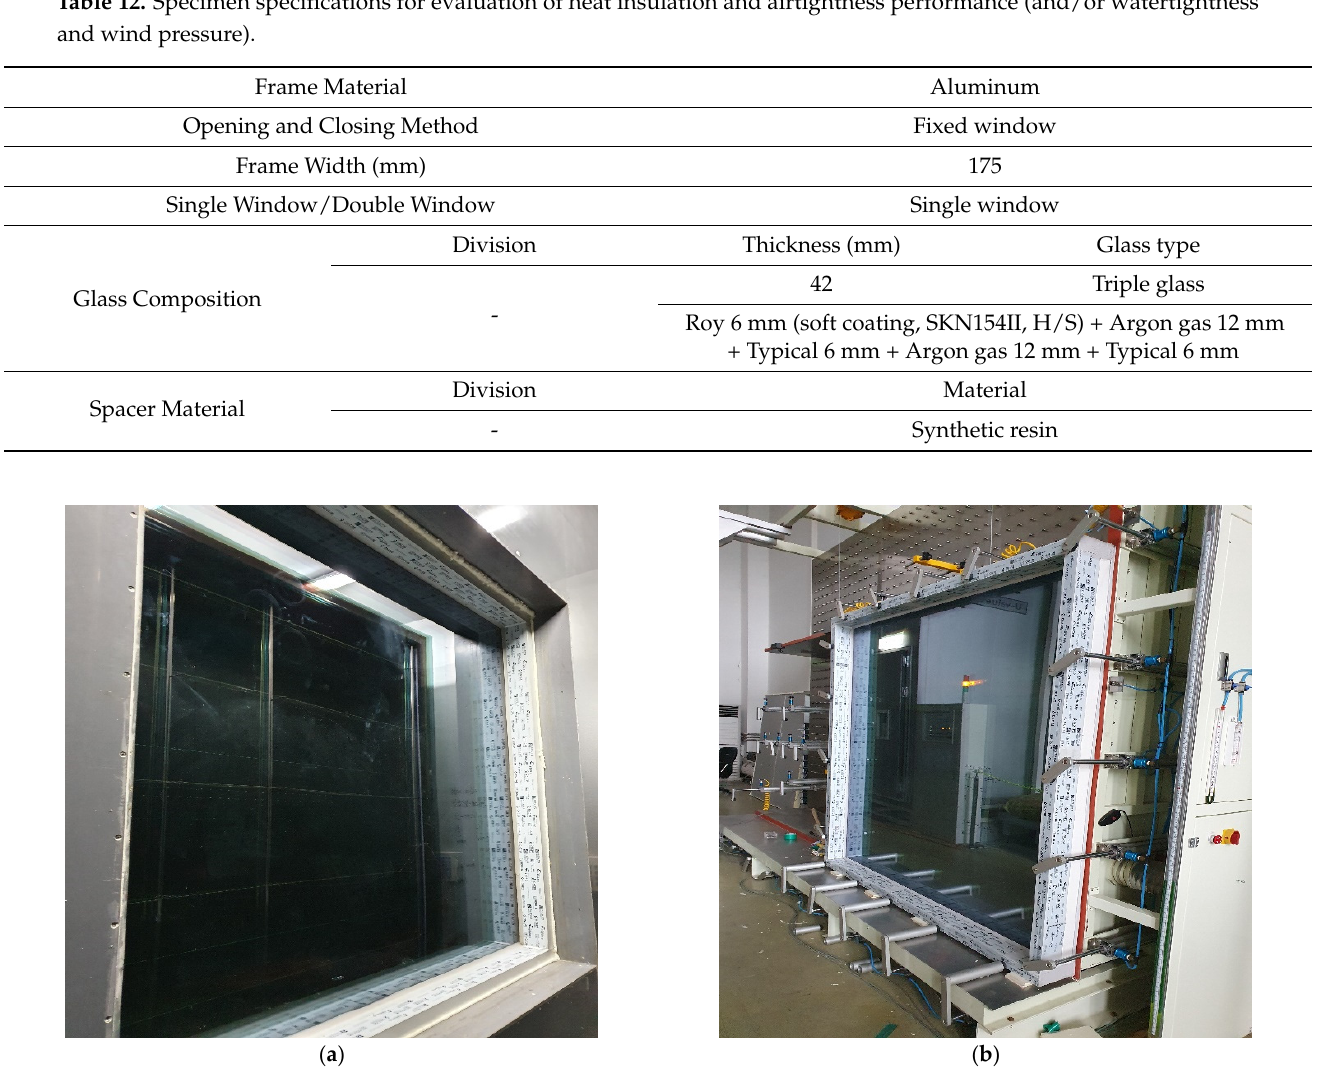
Figure 38. Specimens for evaluating insulation and airtightness performance: ( a ) insulation performance evaluation specimen; ( b ) airtightness performance evaluation specimen.